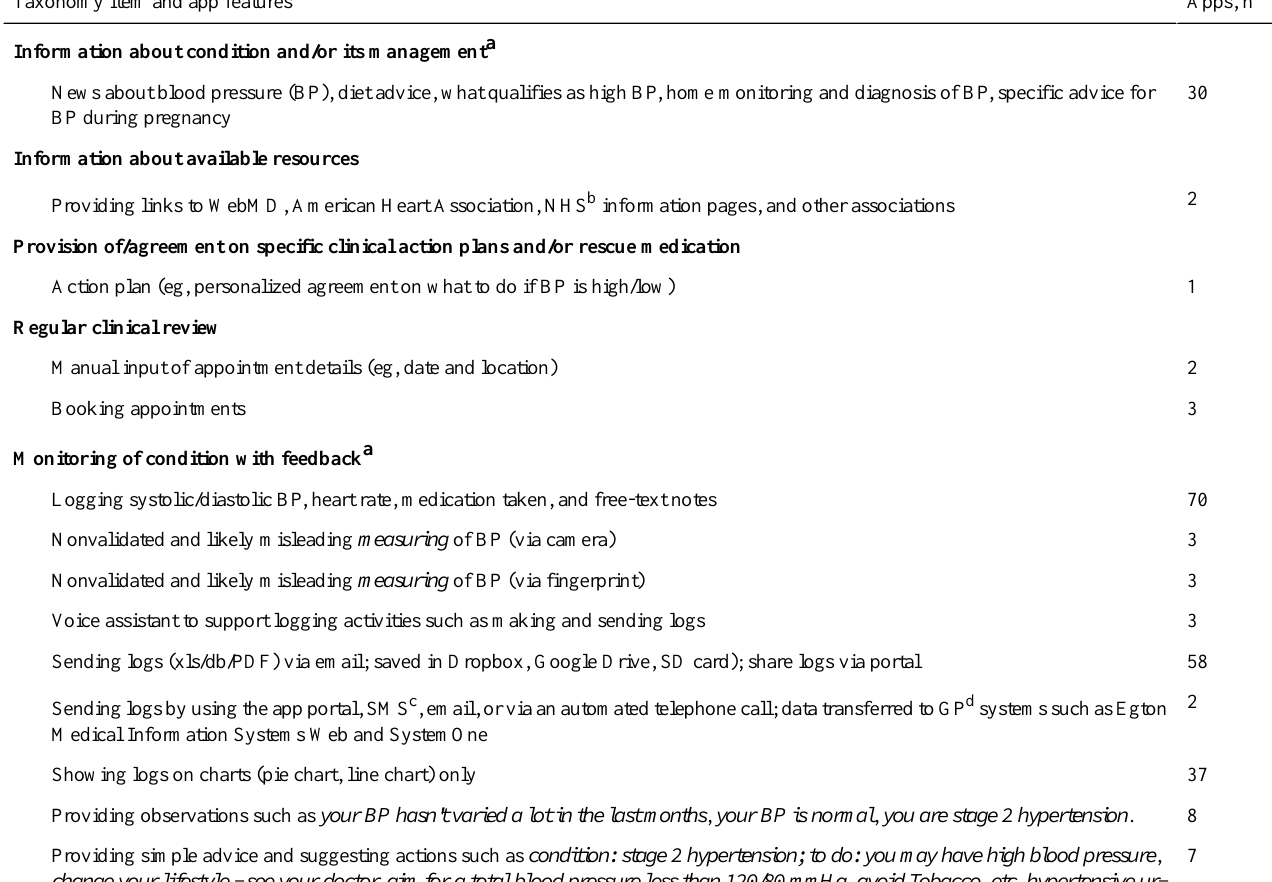
Apps, nTaxonomy item and app